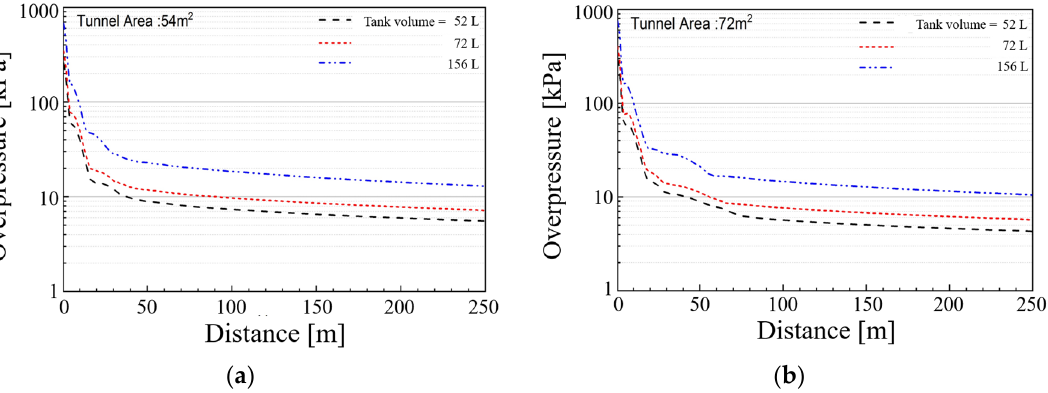
Figure 16. Explosion simulation results at road tunnel: ( a ) tunnel area: 54 m 2 ; ( b ) tunnel area: 72 m 2 .